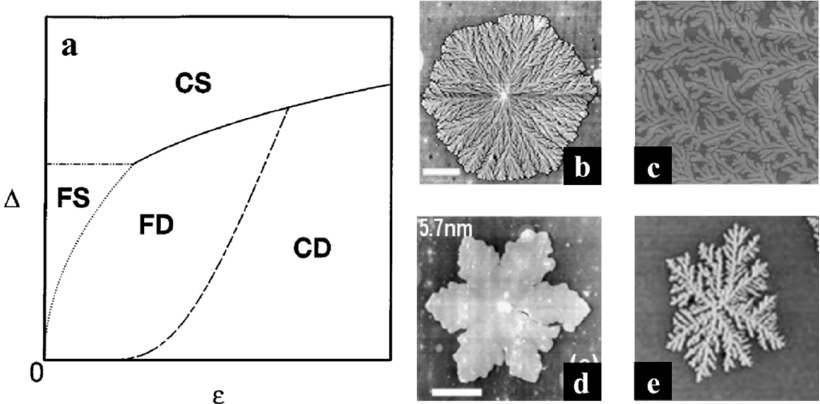
Figure 1. ( a ) Brener et al.’s morphology diagram for polymer crystallized in one-dimensional spatial confinement. In this diagram, ∆ in the y axis represents the degree of supercooling, and ε in the x axis represents the crystalline anisotropy; ( b – e ) Representative crystalline morphologies observed in polymer thin films: ( b ) Compact seaweed (CS); ( c ) Fractal seaweed (FS); ( d ) Compact dendrite (CD); ( e ) Fractal dendrite (FD) [37]. Copyright 2015. Reproduced with permission from Elsevier Ltd.